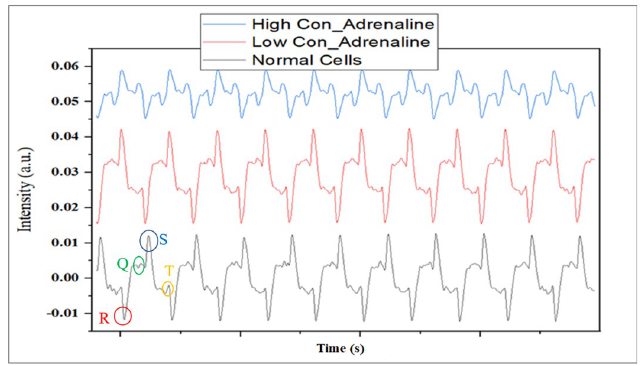
Fig 6. Heart signal from cardio myocyte cells, main signal (first row from bottom), and the signal recorded in stimulated positions with diluted and pure adrenaline.